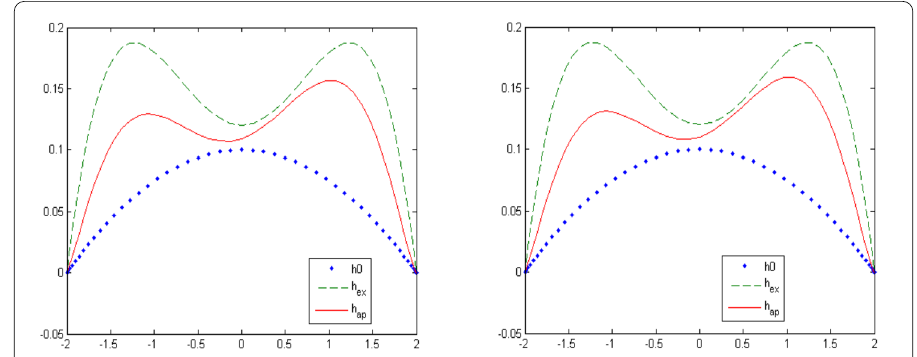
Figure 7 Reconstruction of h 2 after one iteration for exact data (left), and noisy data with δ = 0.01 (right)